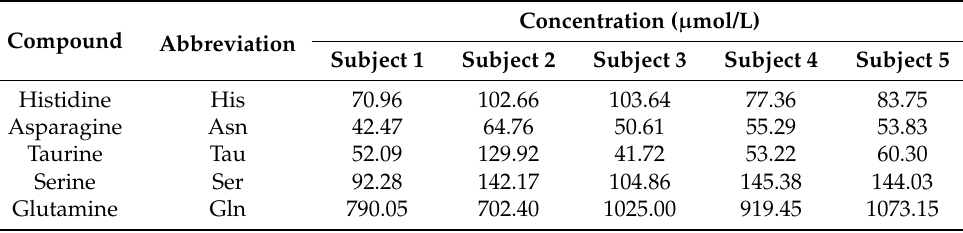
Table 2. Concentration of amino acids and biogenic amines in serum. <LOQ: the molecule was identified with UHPLC-UV analysis, but the concentration was below the limit of quantification, SRM: the molecule was detected by SRM, but the concentration was below the limit of quantification, N.D.: not detected. The data represent the mean value of two technical